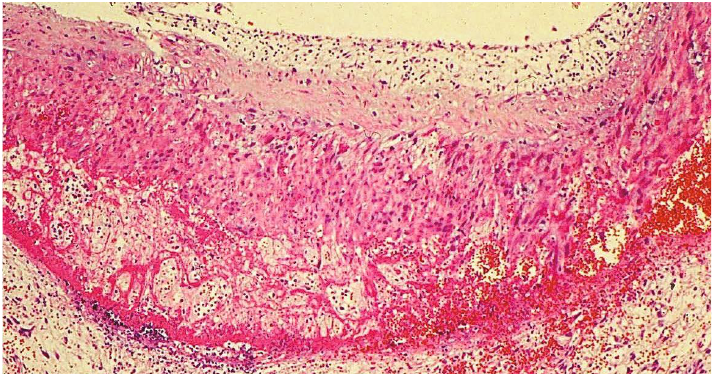
Figure 8: Segmental arterial mediolysis injurious phase. Arrow points to an adventitial-medial tear site outwardly delineated by a linear layer of fi brin. Tear space is edematous and contains fi brin strands and red cells. Fibroblasts and occasional leukocytes are evident in the adjacent adventitial tissue. Hematoxylin & eosin × 100 (adapted with permission from Modern Pathology 8(3) copyright 1995, Nature Publishing